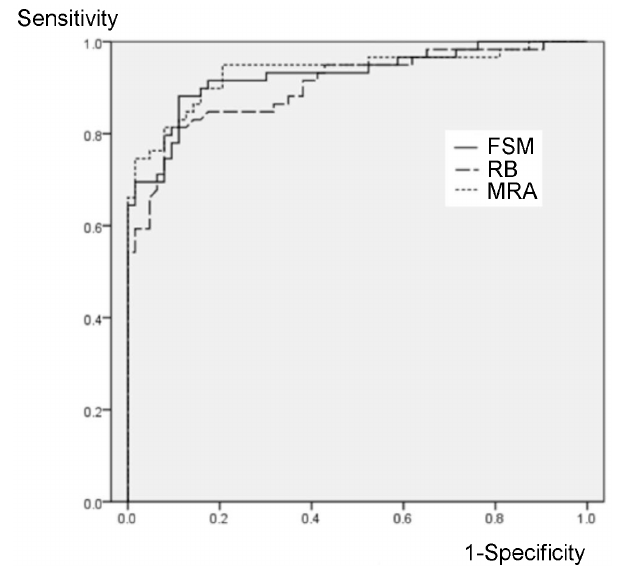
Figure 1. ROC curves for diagnosis of glaucoma in emmetropic eyes. AUCs of FSM or RB Discriminant Function and MRA